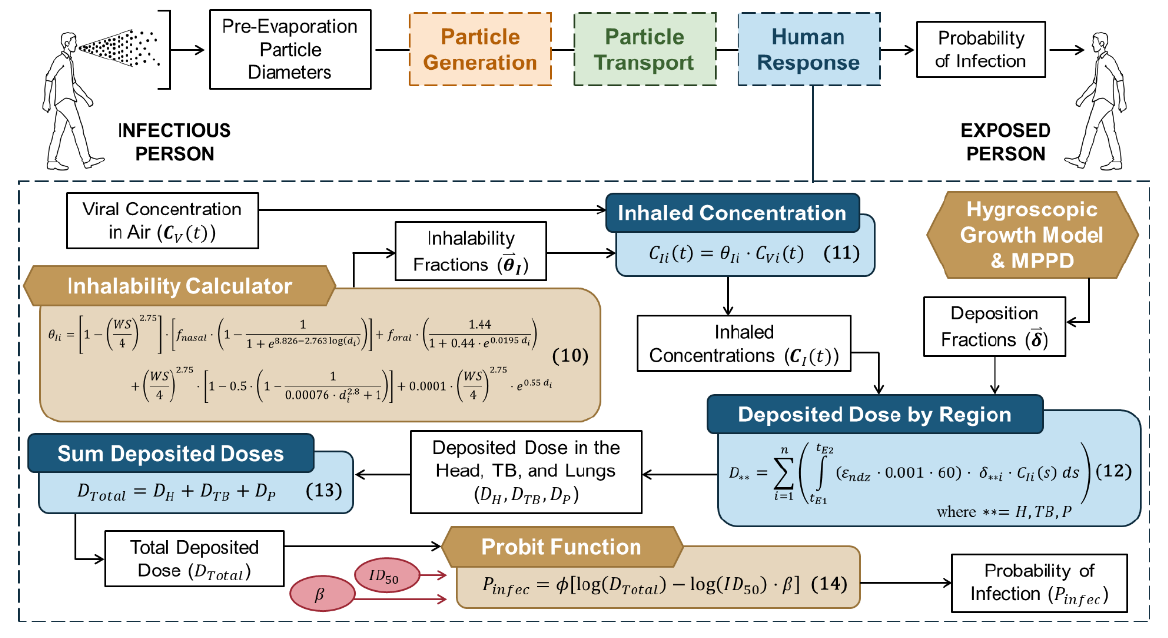
Figure A4. Visualization of the human response submodel workflow. Red circles indicate parameters selected for sensitivity analysis (see Section 2). All notation definitions are provided in Table 1.